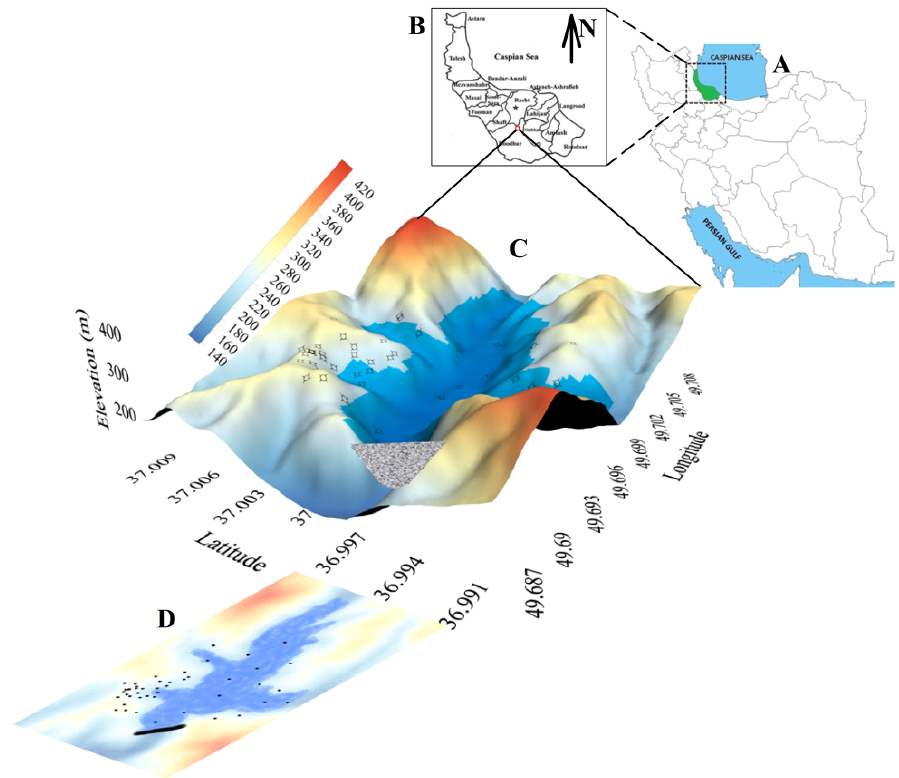
Figure 5. Location of studied area in Iran ( A ) and Guilan province ( B ), generated DEM and overlaid spatial data ( C ), and distribution of geospatial surveyed drilled boreholes ( D ).